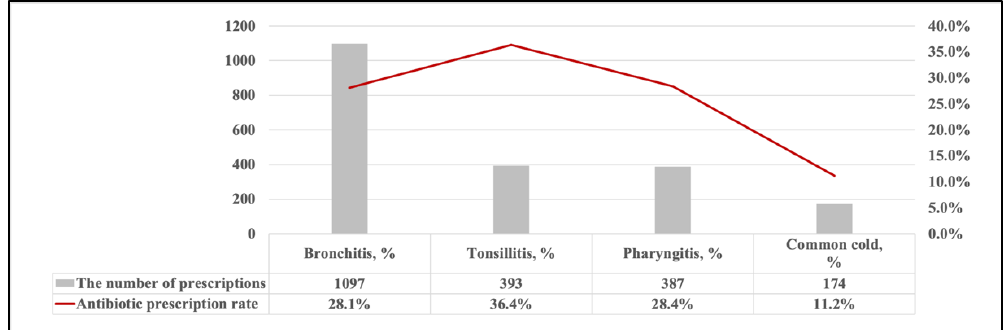
Figure 2. Antibiotic prescription rate of common infections in outpatient antibiotic prescriptions for children.